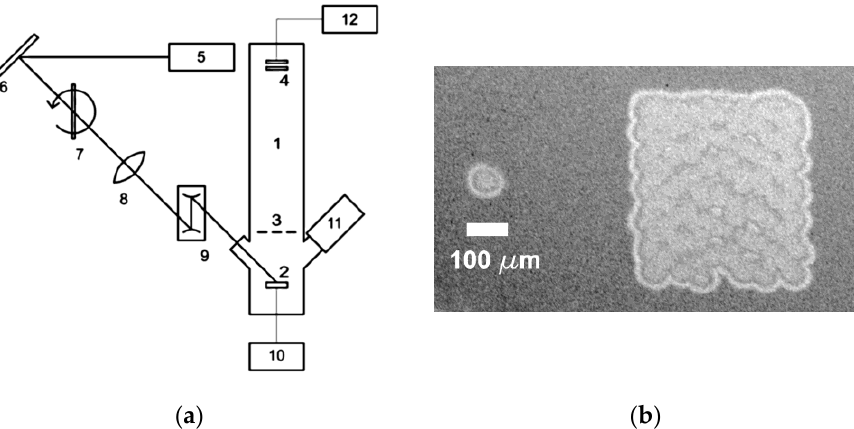
Figure 1. ( a ) Experimental setup: 1 — time-of-flight mass spectrometer, 2 — gold plate, 3 — ion source grid, 4 — ion detector, 5 — laser, 6 — mirror, 7 — attenuator, 8 — lens, 9 — scanner, 10 — high voltage power supply, 11 — CCD camera, and 12 — data acquisition board. ( b ) The laser damage spots on the silicon wafer surface in static mode (left) and scanning mode (right).